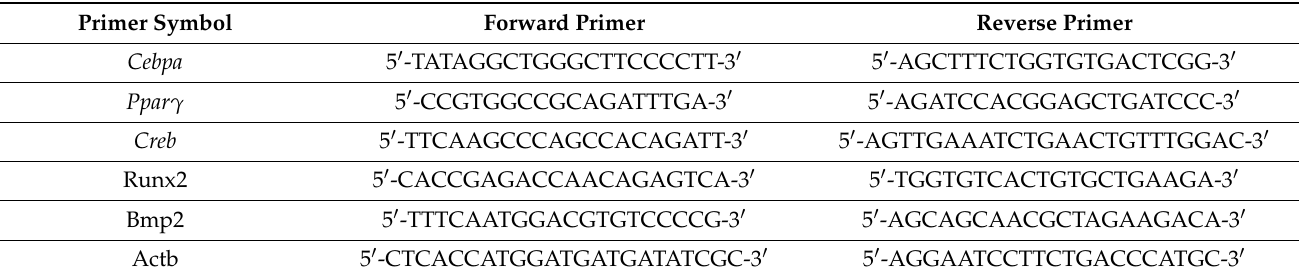
Table 1. Primer sequences used in real-time PCR.